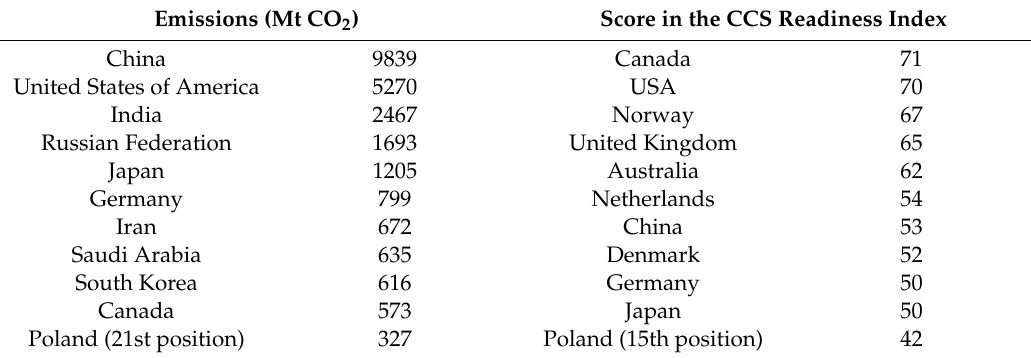
Table 1. Top 10 emissions countries versus top 10 Carbon Capture and Storage (CCS)-ready countries [4,5].